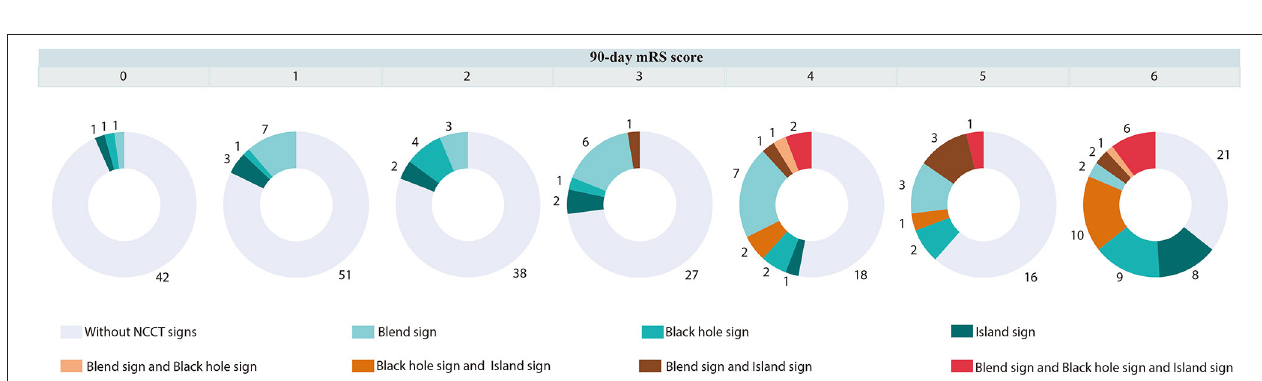
FIGURE 2 | Distribution of mRS in patients with or without blend sign, and (or) black hole sign, and (or) island sign. mRS indicates a modified Rankin Scale.